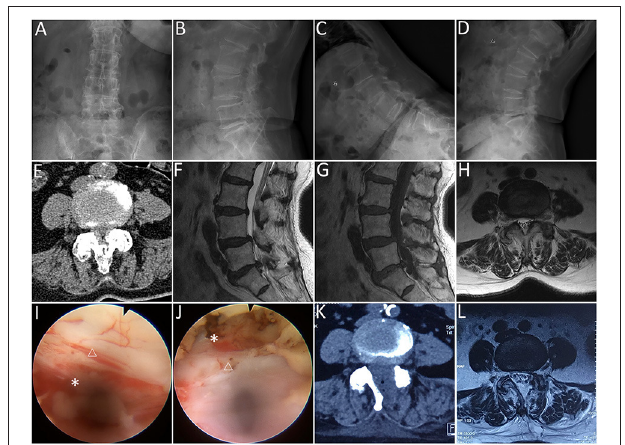
FIGURE 2 | Lumbar endoscopic unilateral laminotomy bilateral decompression (LE-ULBD) performed on a 77-year-old female patient diagnosed with L4-L5 lumbar spinal stenosis with degenerative spondylolisthesis. (A,B) preoperative anteroposterior and lateral plain radiographs; (C,D) preoperative flexion and extension radiographs; (E) preoperative computed tomography (CT) scans; (F–H) preoperative magnetic resonance imaging (MRI) scans; (I,J) medial facetectomy was performed to decompress the lateral recess and ensure adequate decompression of the traversing nerve root; (K) postoperative CT scans; (L) postoperative MRI scans. Snowflake, nerve root, triangle, dural sac. * is used to tell the readers where is the nerve